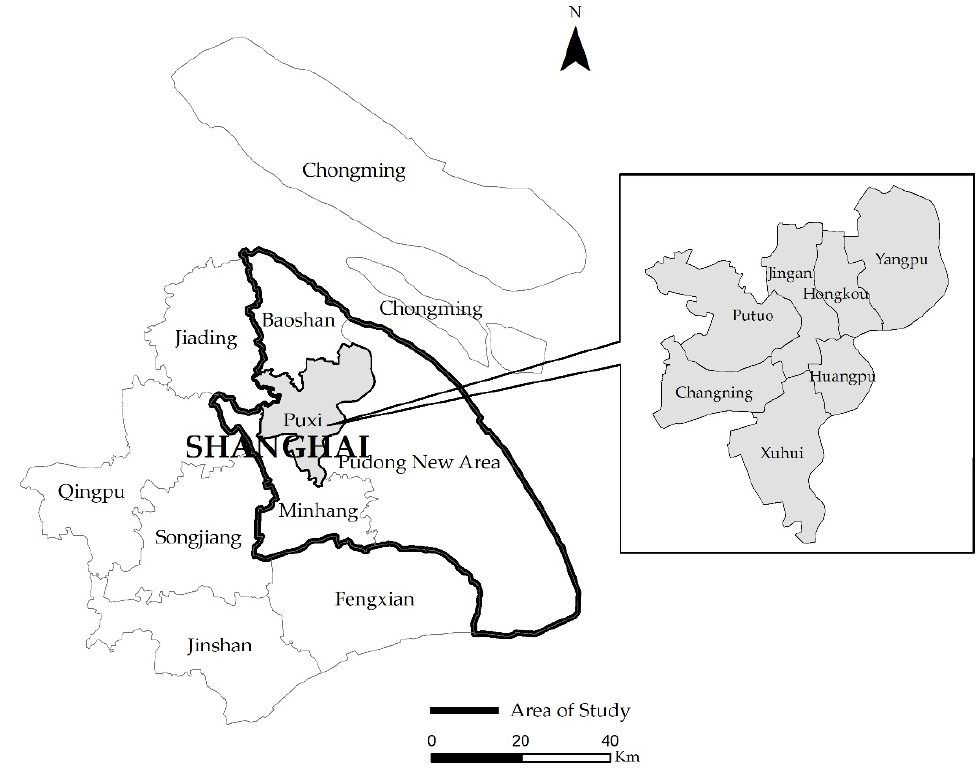
Figure 1. Map of